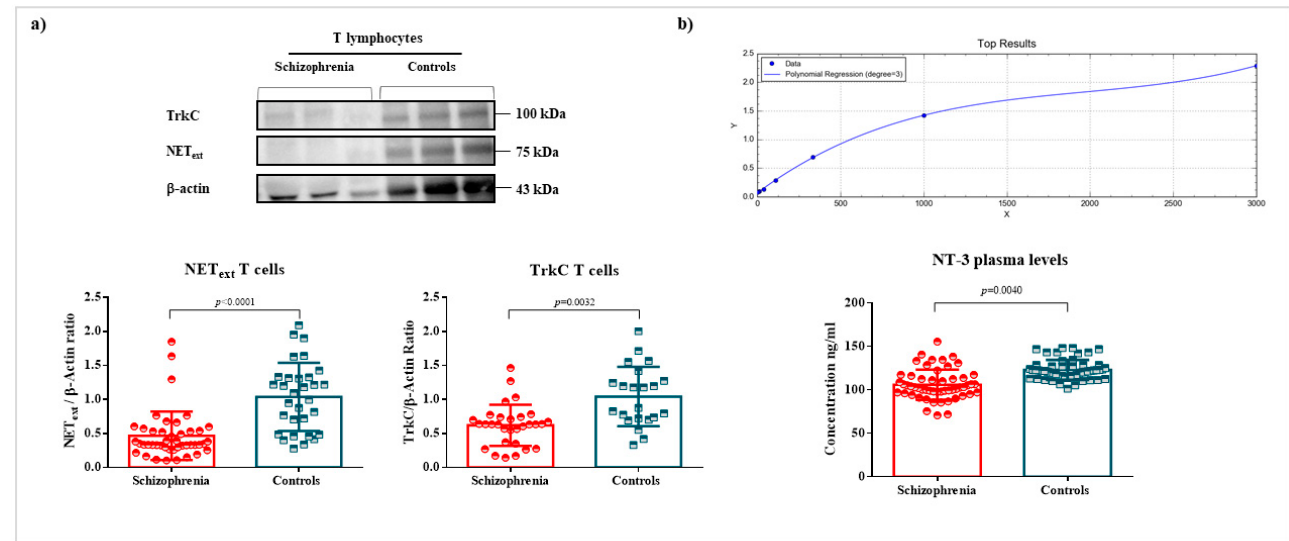
Figure 1. Levels of NET and TrkC in T cells, and NT-3 in plasma. Legend: quantification of NET and TrkC levels in T cells and NT-3 in plasma, and their respective scatter plots and bar graphs (mean ± SD). ( a ) NEText (45 patients with schizophrenia vs. 31 controls) and TrkC (31 patients with schizophrenia vs. 22 controls) levels were measured by Western blot and normalized with the housekeeping protein β -actin. Relative units refer to the mean of control values after normalization. The results showed a reduction in NET levels ( p < 0.0001) and TrkC levels ( p = 0.0032) in T cells of patients with schizophrenia compared to the control group. ( b ) The analysis of NT-3 (54 patients with schizophrenia and 54 healthy controls) in plasma revealed a reduction in this neurotrophin in the plasma of patients in comparison with controls ( p = 0.0040), whose concentration was measured by ELISA using a polynomial regression method (Y = absorbance; X = concentration, degree = 3; R 2 = 0.9999).